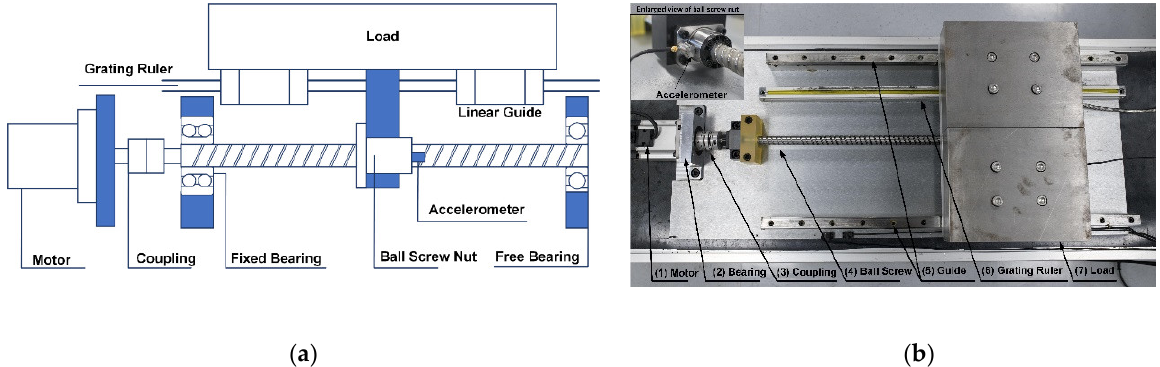
Figure 13. ( a ) Schematic of the ball screw test platform. ( b ) Photograph of the ball screw test platform.